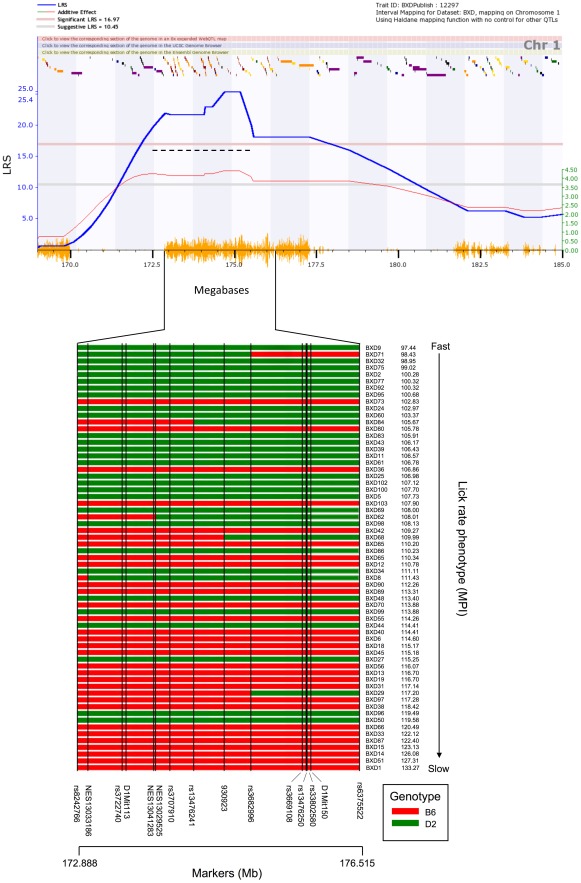
Interval QTL map on part of chromosome 1 for water MPI.Blue trace denotes LRS score, and red trace shows additive effect of the B6 allele. Values for the additive effect are shown in green at right. The LRS score exceeds the threshold for genome-wide significance (pink horizontal line; p<0.05). The dashed black line indicates the confidence interval of the QTL, defined by a 1.5 LOD drop on either side of the peak. Orange seismograph marks indicate SNP density, and colored ticks at top of plot show positions of known genes. Below plot, haplotype distribution among BXD strains is shown for part of the peak QTL region, between the SNP markers rs8242766 and rs6375522. D2 (D/D) genotype is indicated by green bars and B6 (B/B) by red bars. Strains in this table are ordered according to MPI score, from fast to slow (top to bottom). The D2 genotype is associated with faster lick rates, as reflected in low MPI values in strains possessing this genotype in the QTL region.